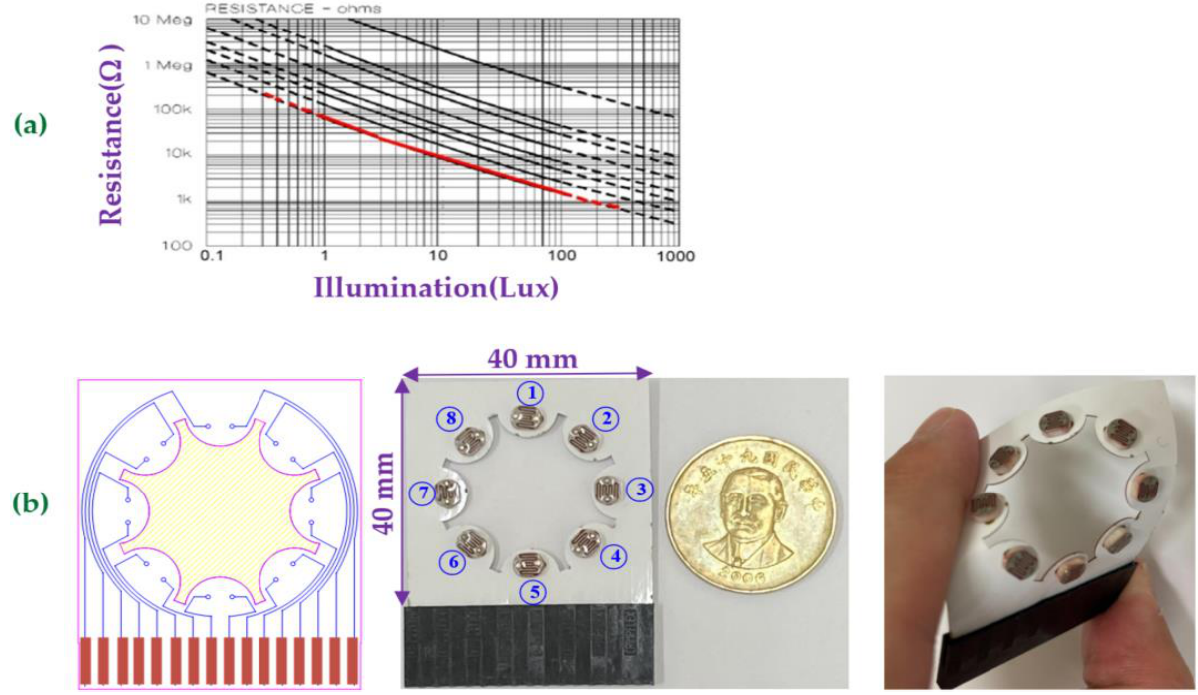
Figure 4. ( a ) Correlation cu rve showing resistance (Ω) as a function of light intensity (Lux) as meas- Figure 4. ( a ) Correlation curve showing resistance ( Ω ) as a function of light intensity (Lux) as ured using the light sensor (log-log). ( b ) Flexible ring-light sensor array. measured using the light sensor (log-log). ( b ) Flexible ring-light sensor